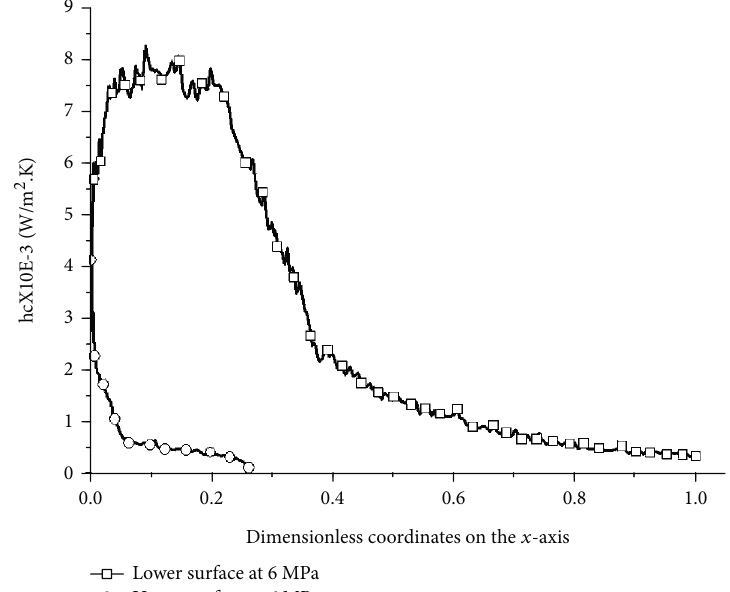
Figure 5: Heat transfer coe ffi cient of the inner surface in Figure 1.